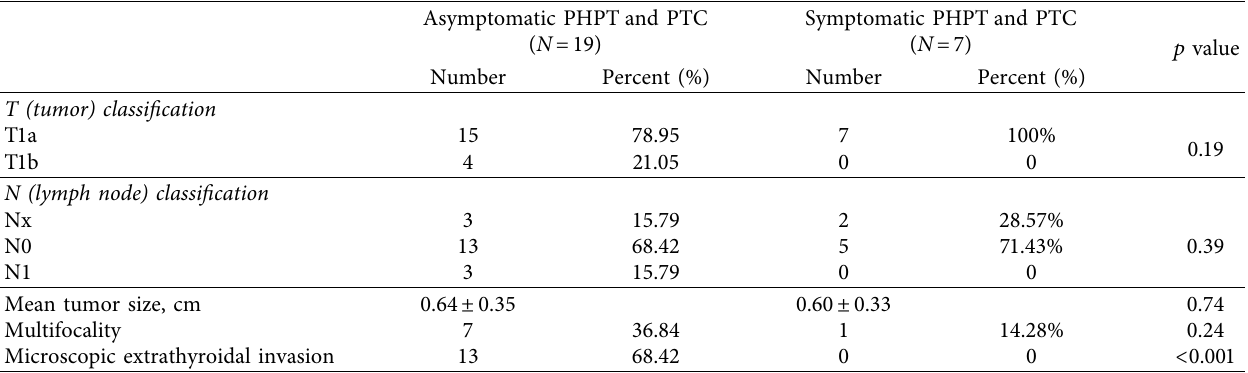
Table 3: Pathological characteristics of papillary thyroid carcinoma in asymptomatic PHPT and symptomatic PHPT patients. Asymptomatic PHPT and